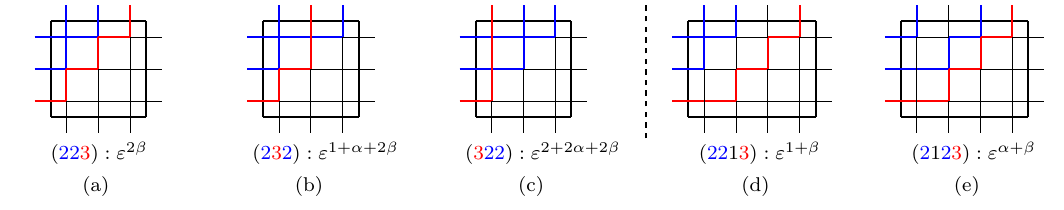
Figure 5 . The vertices inside the box for M = 3 , K = 1 for the leading configurations. For (d) and (e), ε − β in (3.62) is multiplied. (a) is the most dominant. the right, except for the one in the upper left corner. We also add one new vertical black line, as well as a single vertical black edge, namely to the right of the blue upper-left-corner edge. An example for this may be found in figure 5, where the procedure creates (e) from (a). The ensuing power of ε is (2 K + 1 − M ) + ( M − K − 1) α + K [ M − ( K + 3) / 2] β